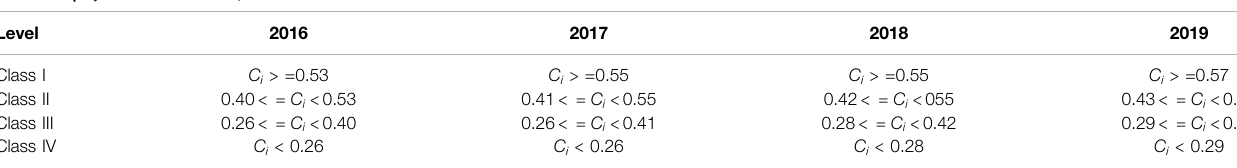
TABLE 3 | Synthetic measure C i